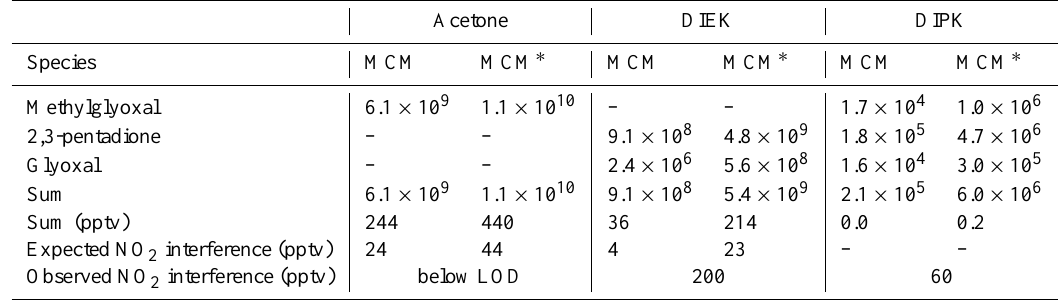
Table 3. Yields of major α , β -dicarbonyls produced as byproducts in the photocell (in moleculescm − 3 unless stated otherwise). Acetone DIEK DIPK Species